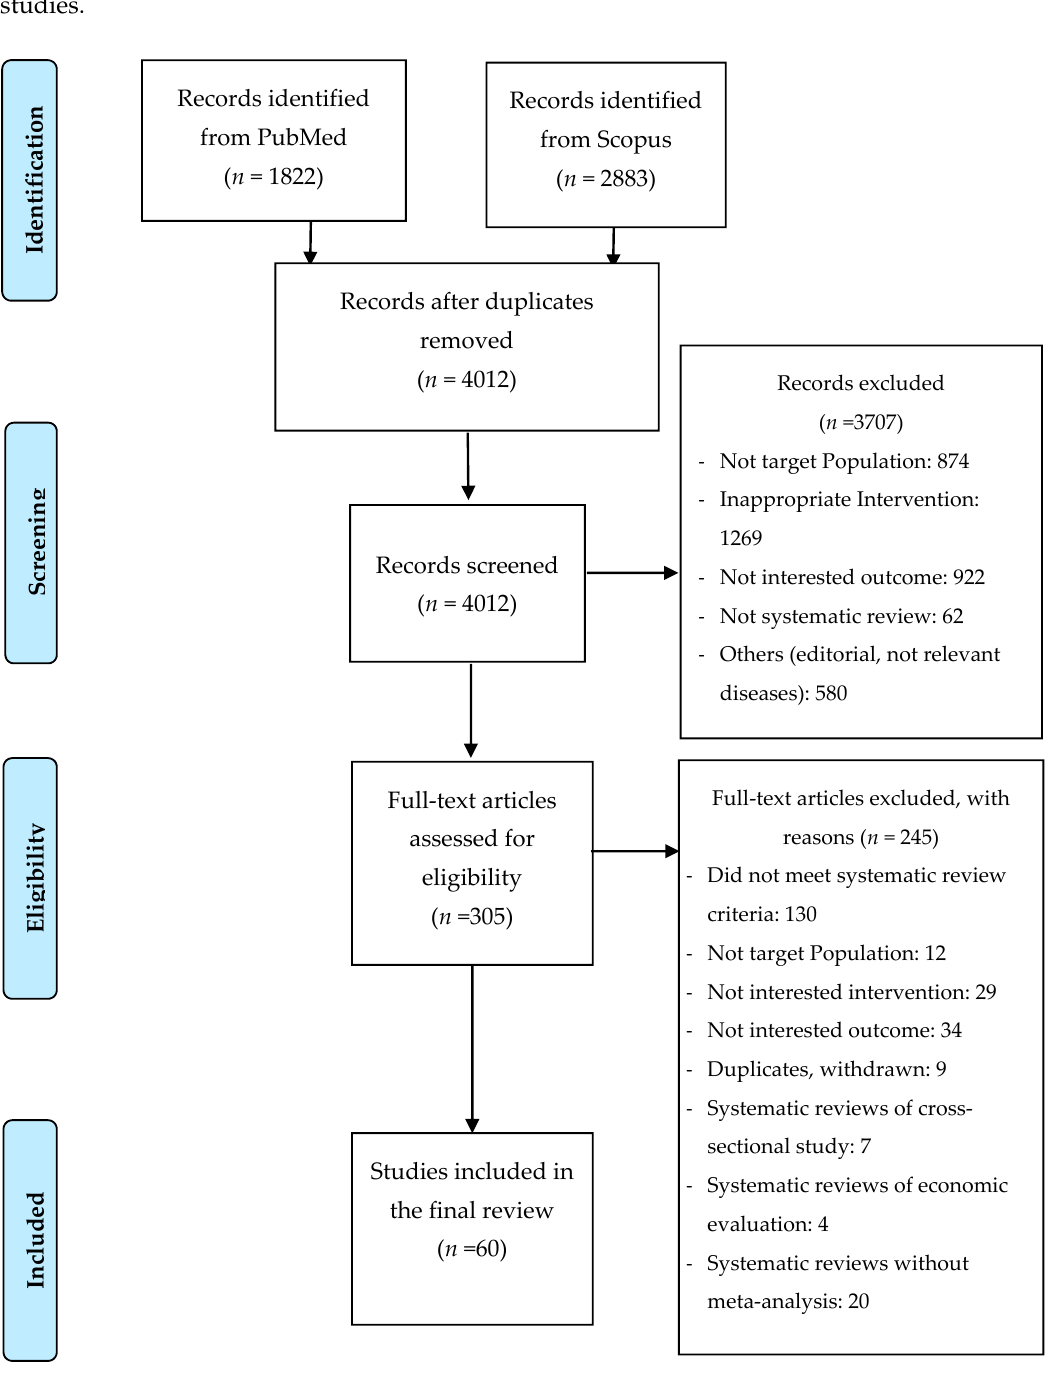
Figure 1. Flow diagram of study selection.